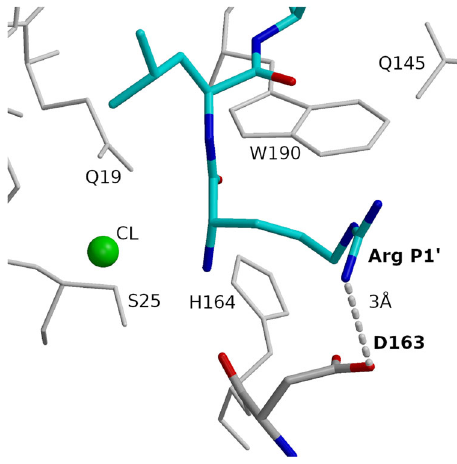
Fig. 6 Binding speci fi city between Arg at P1 ′ and D163 (cathepsin V). Arg and Leu of peptide RLSAKP (non-protected), bound at subsites S1 ′ and S2 ′ are shown in the bond model in blue (nitrogen), red (oxygen), and cyan (carbon). D163 is shown in the bond model in blue (nitrogen), red (oxygen), and gray (carbon). Hydrogen bond is shown with a dashed line. Neighboring residues and the chlorine ion are also provided. Figures in the panel were prepared using MAIN 59 and rendered using Raster 3D 66